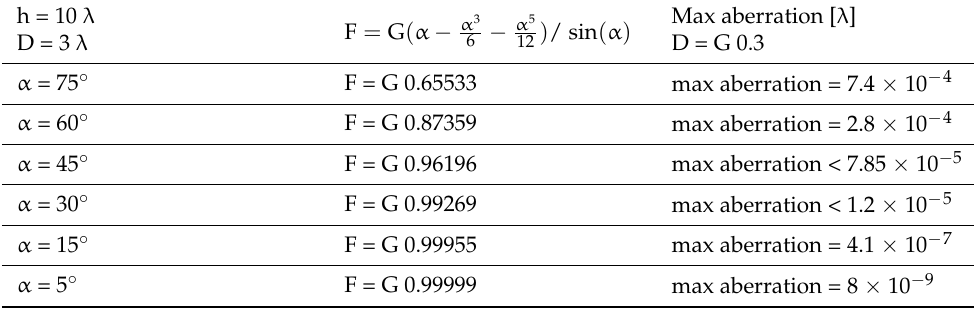
Table 5. Aberrations and lateral focal distance for lenses having h/D = 10/3, M = 1.